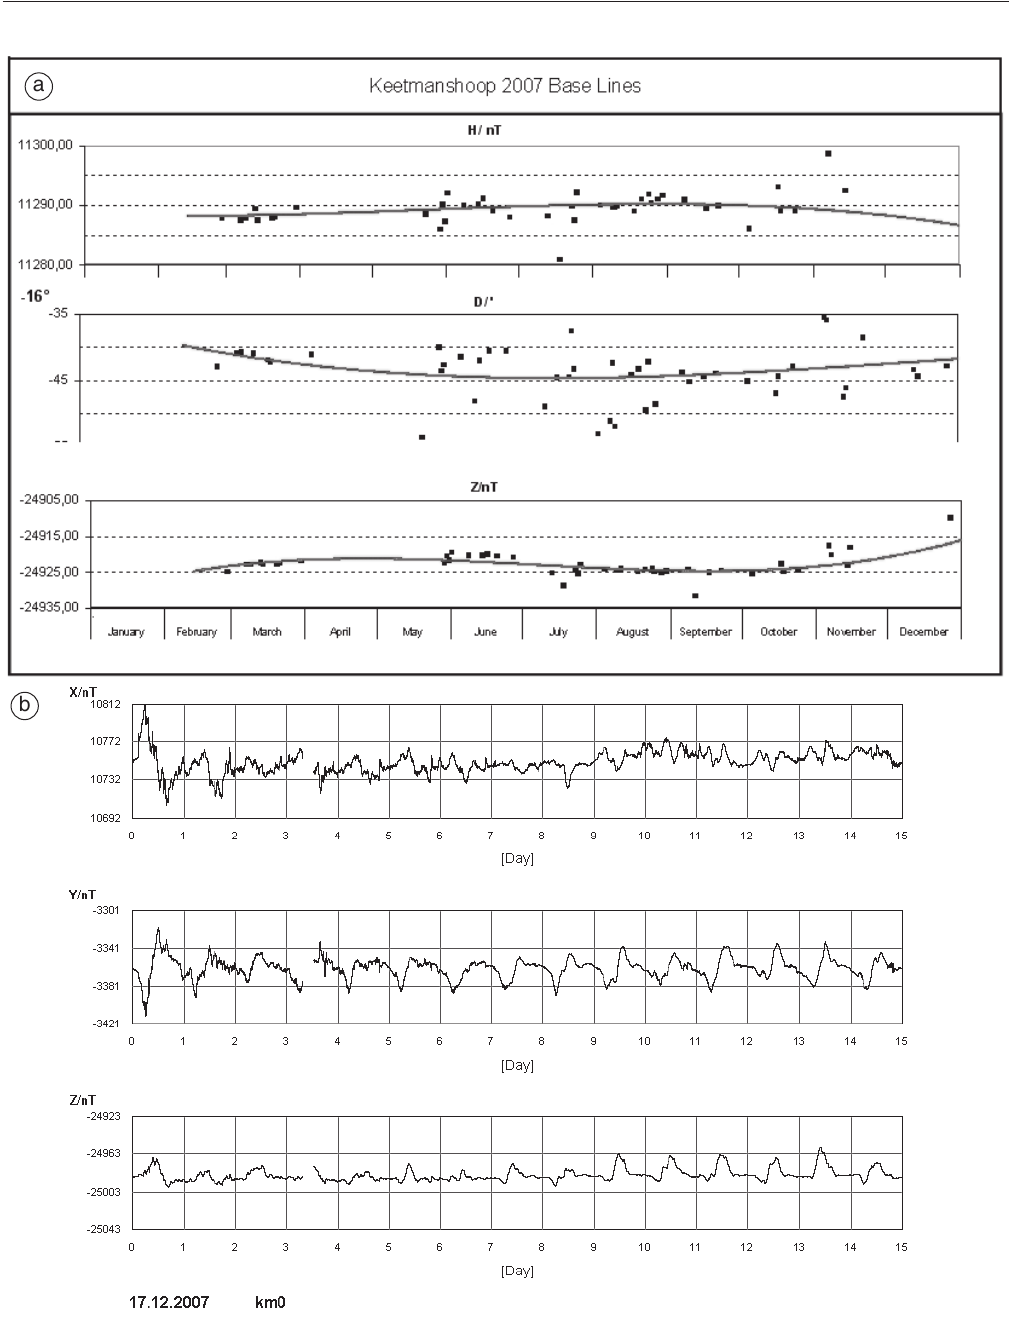
Fig. 7a,b. Expamples for data from KMH observatory. a) Measured (black dots) and adopted (grey line) base lines for 2007. b) One minute values of the north (X), east (Y) and vertical (Z) component for the time interval December 17 to 31,